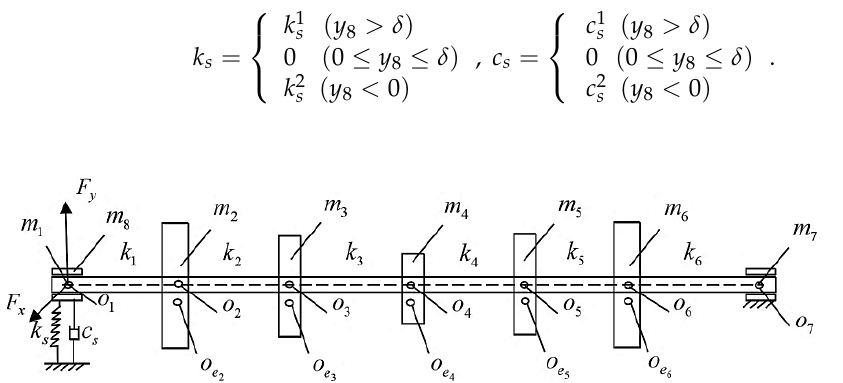
Figure 1. Schematic diagram of a high-dimensional nonlinear rotor-bearing system.